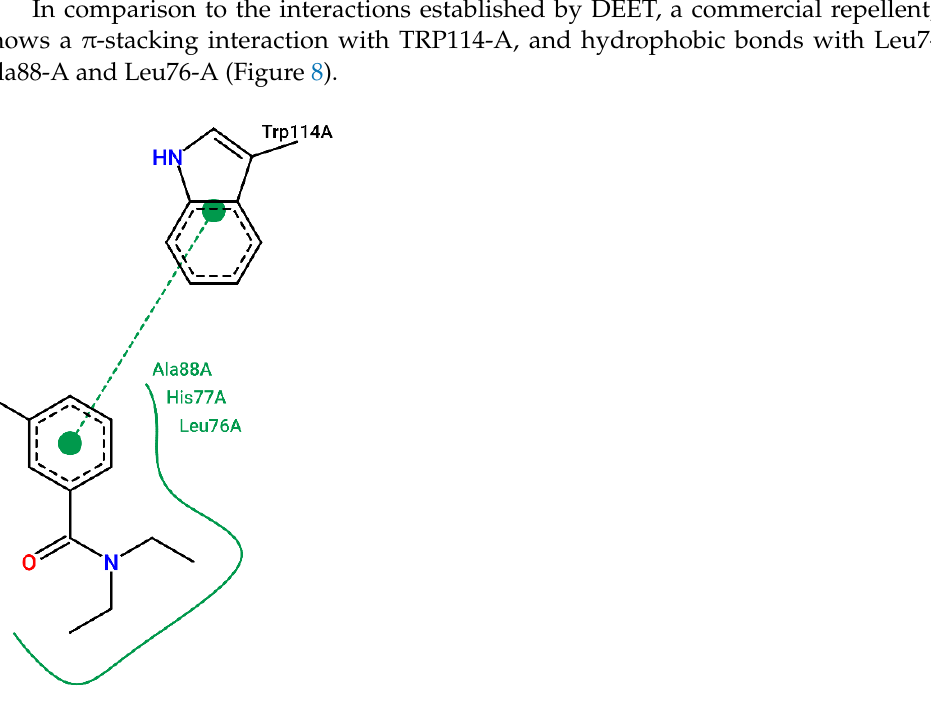
Figure 8. Crystallographic ligand interaction map in the PoseView software generated at the Aaeg OBP1 binding site. (Legend: Ligand: Carbons are represented in green, nitrogen in blue and oxygen in red).